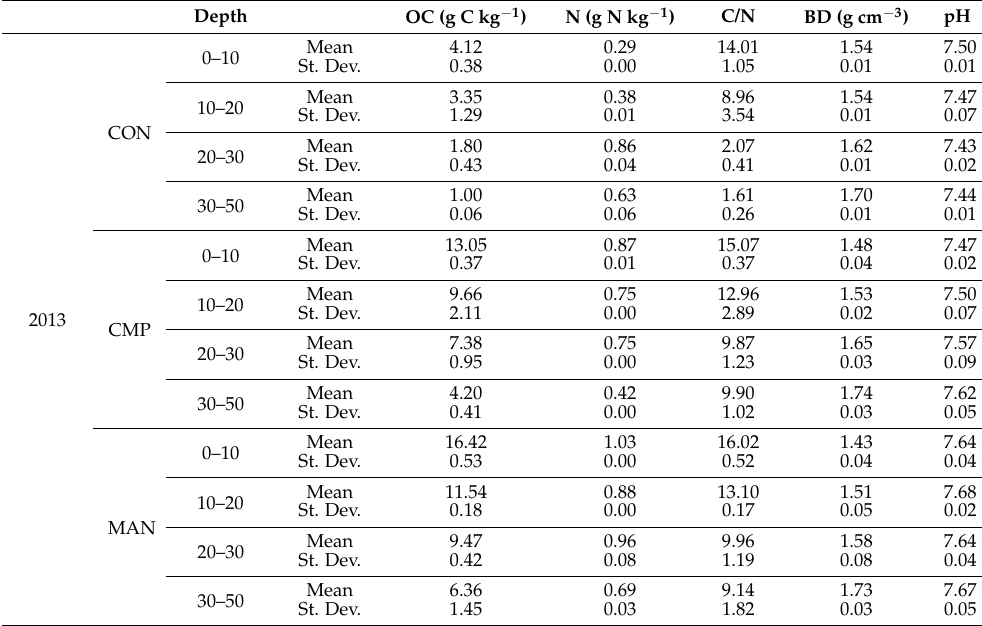
Table 2. Soil properties in the three plots under the three treatments between 2013 and